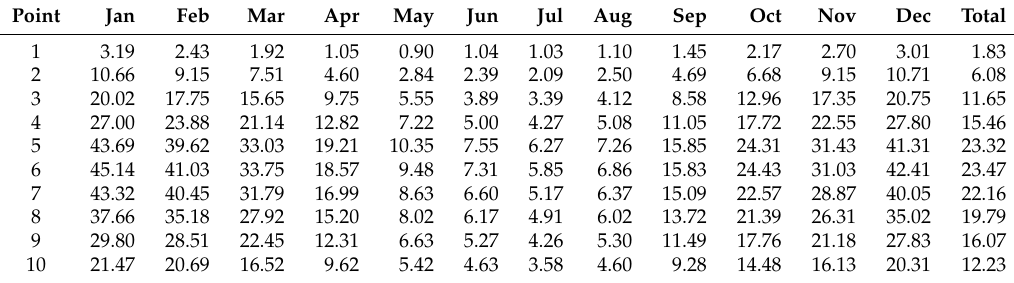
Figure 8. Boxplots based on the 59-year period for ( a ) swell-induced and ( b ) wind-sea-induced WEF as well as ( c ) total WEF (kW m − 1 ) for the 10 selected offshore points (x-axis). ( d ) Definition of boxplot used in this study, where the whiskers are set at specific percentiles (5, 95) of the data. Table 2. Average monthly WEF s (kW m − 1 ) for the 10 selected